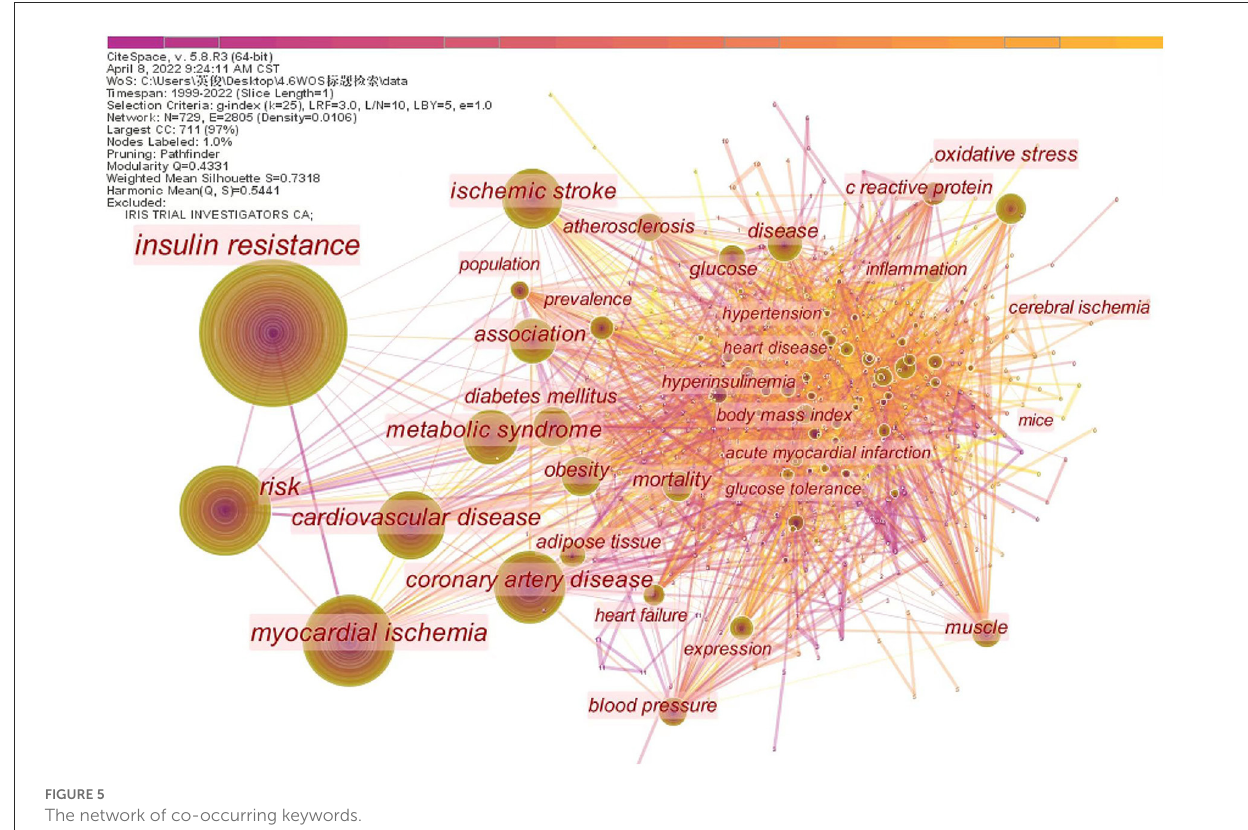
FIGURE5 The network of co-occurring keywords.